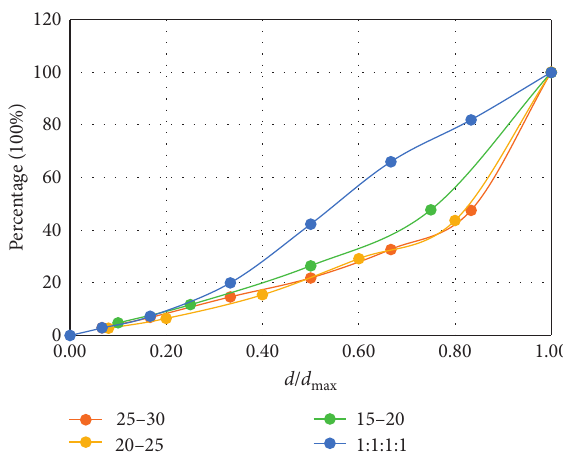
Figure 6: The redistribution of particle size after the sample was loaded and crushed.